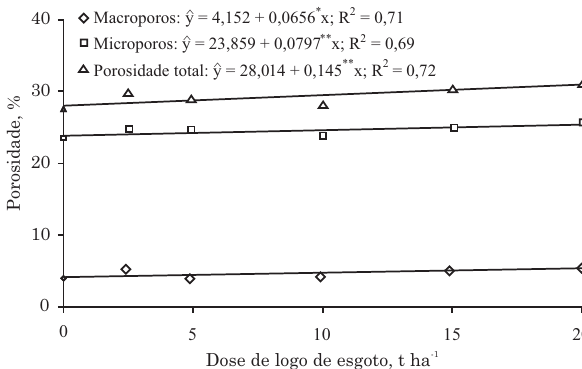
Figura 3. Porosidade do solo em função de doses de lodo de esgoto, adicionado ao solo seis meses após sua aplicação. * = significativo a 5 %, ** = significativo a 1